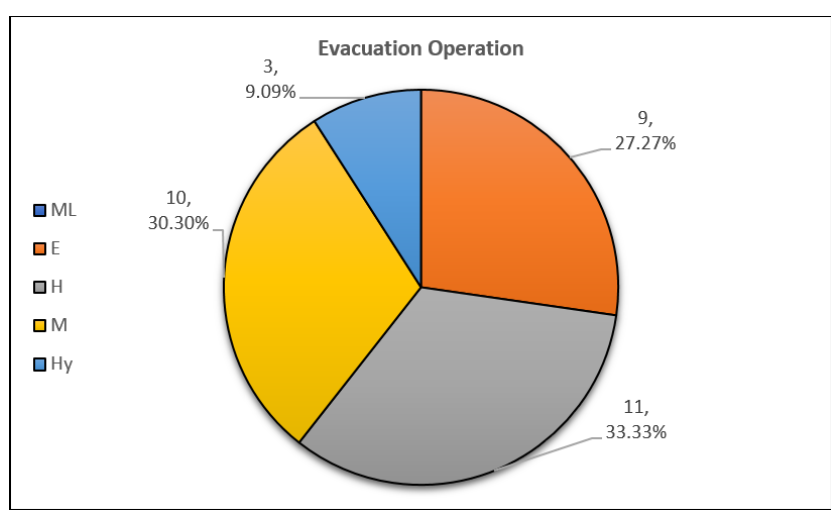
Figure 34. Breakdown of VRP for Rescue Operation based on Solution Approach.